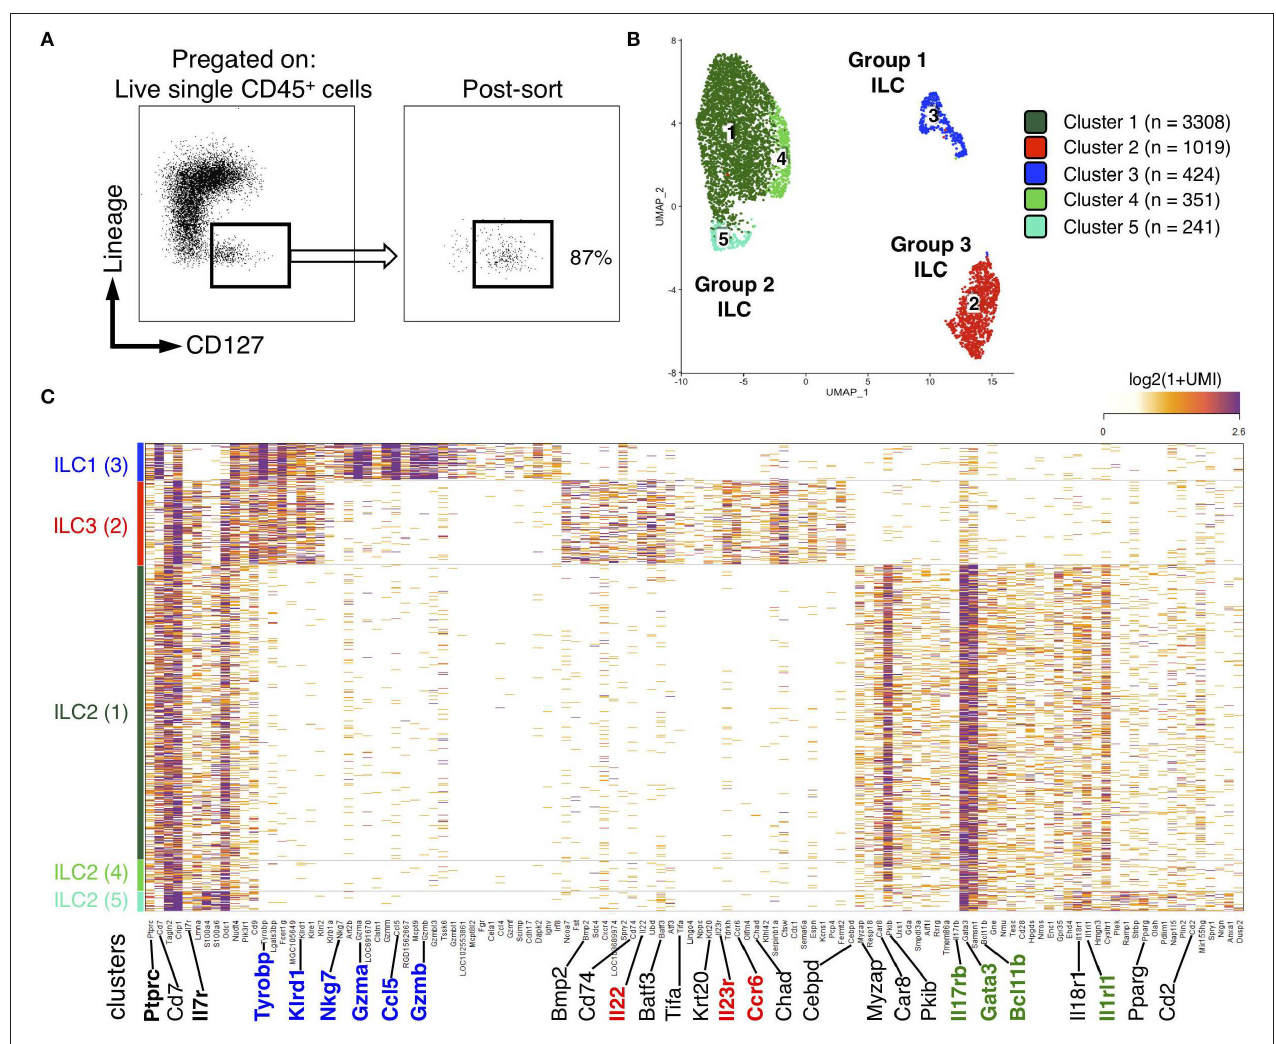
FIGURE 2 | scRNAseq reveals distinct clusters of ILCs from colon LP of rat. (A) FACS-sorting plots showing the sorted CD45 + Lin − CD127 + ILCs from the colon LP of one SPD rat (left panel) and cells purity after sorting (right panel). (B) Uniform manifold approximation and projection (UMAP) visualizing clusters of colonic Lin − CD127 + cells analyzed by scRNAseq ( n = 1 SPD rat). (C) Heatmap visualization color-coding the mRNA (UMI) counts per single cells (stacked rows) for selected genes (columns). Visualized are randomly selected cells, which were downsampled to 2,000 UMIs/cell. Clusters are separated by gray bars and ordered by ILC